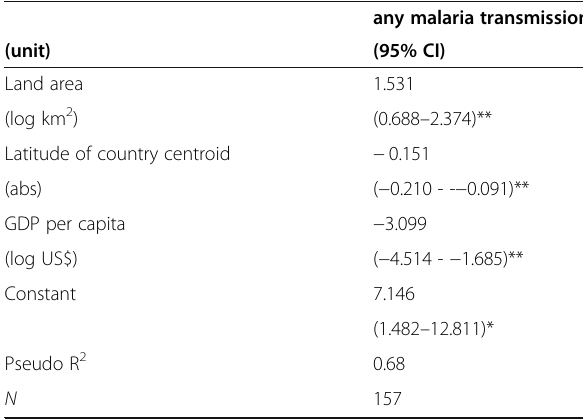
Table 3 Logistic regression model of any malaria transmission any malaria transmission